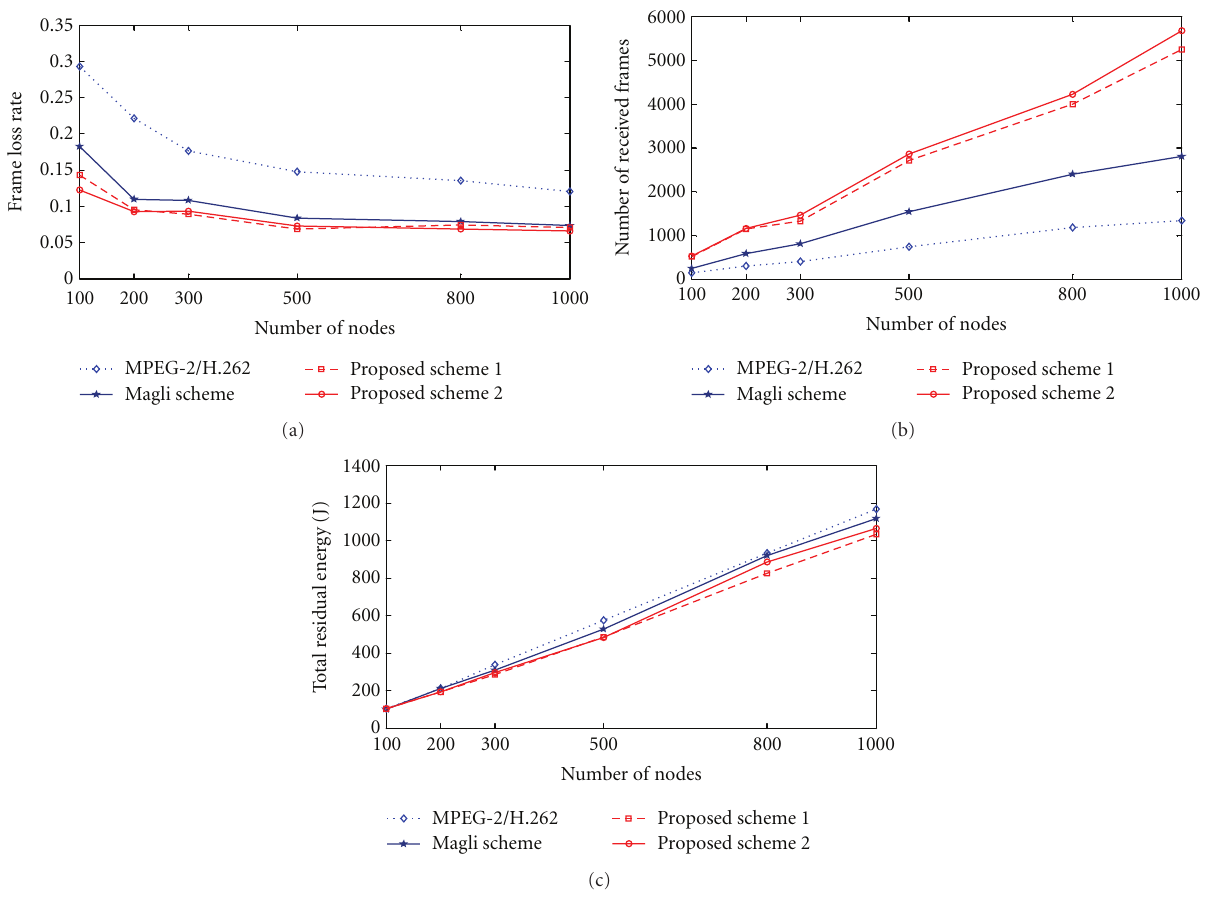
Figure 16: The results obtained for four schemes with QCIF Akiyo video in case of having channel error: (a) the average frame loss rate, (b) the number of received frames, and (c) the total residual